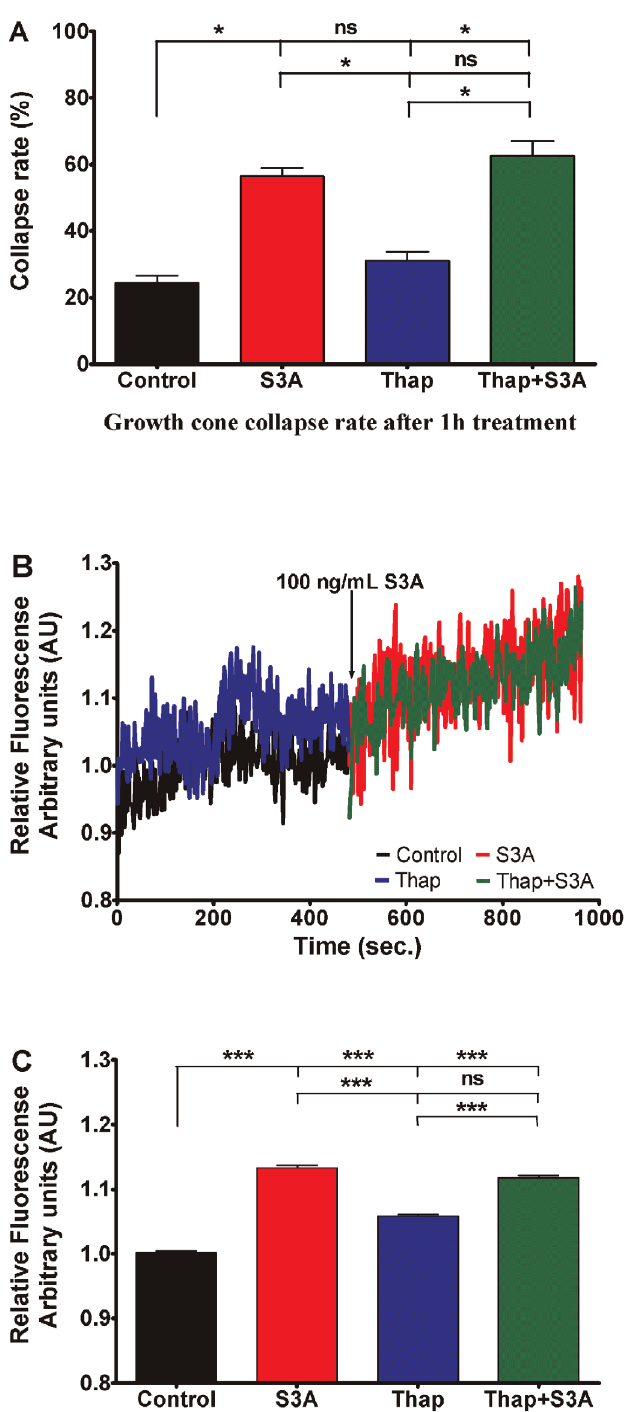
Figure 4. Influence of SERCA inhibitor thapsigargin (1 m M) on Sema3A (100 ng/mL) induced effects. A) 1 hour incubation with endoplasmic reticulum SERCA inhibitor had no significant effect on growth cones of mouse E15 DRG growth cone collapse rate (red bar) comparing to control conditions (black bar). Also, thapsigargin along with Sema3A (green bar) did not change Sema3A collapse-inducing effect (blue bar). B) Changes of relative Fura-2 340/380 fluorescence in control conditions (black curve) and 1 m M of thapsigargin (blue curve) followed by DRG neuron treatment with Sema3A (red and green curves respectively) at indicated time point. All data have been normalized to the point preceding Sema3A addition (this point equals to 1 arbitrary unit AU). C) Bars represent fluorescence mean 6 SEM: black bar represents control Fura-2 fluorescence; red bar represents mean fluorescence in presence of Sema3A; blue bar indicates condition in presence of thapsigargin and green bar indicates conditions where Sema3A was added in presence of thapsigargin. Here S3A and Thap corresponds to Sema3A and thapsigargin respectively; ***p , 0.001; *p , 0.05; ns – not significant. In the panels A and C upper, middle and lower lines represent statistical difference of the corresponding groups from control, from Sema3A, and thapsigargin groups respectively.